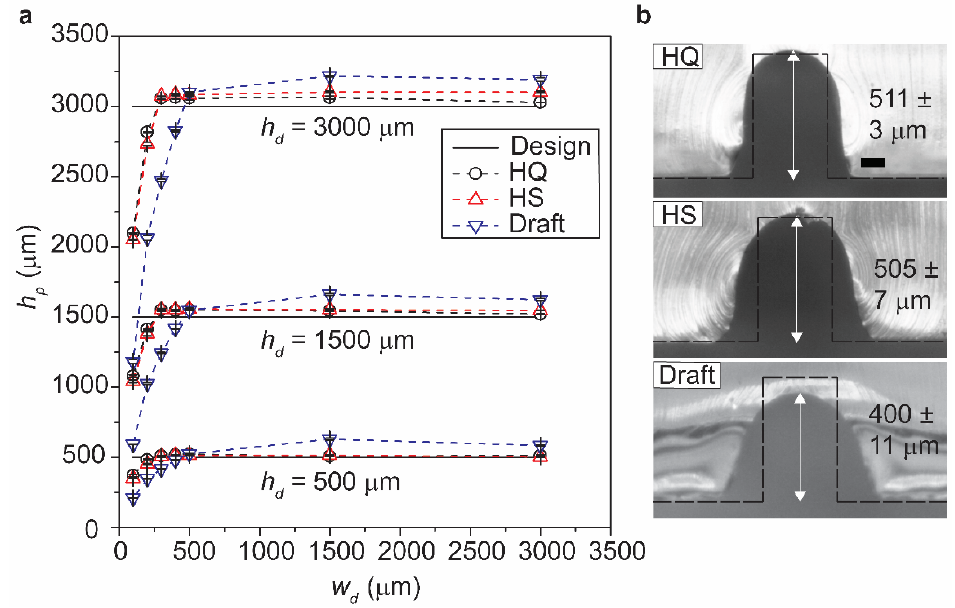
Figure 4. ( a ) Plot of h p against w d for the three different layer thickness: HQ (16 µm), HS (28 µm), and Draft (36 µm) for h d = 500, 1500 and 3000 µm. HQ and HS modes required w d = 300 µm to achieve h p > h d , while Draft mode required w d = 500 µm to achieve h p > h d . ( b ) Microscopic images showing the cross-section of designed and printed cuboid-shaped structures replicated in PDMS for the three different modes of printing. The microstructures were with w d = 300 µm and h d = 500 µm. Scale bar = 100 µm.